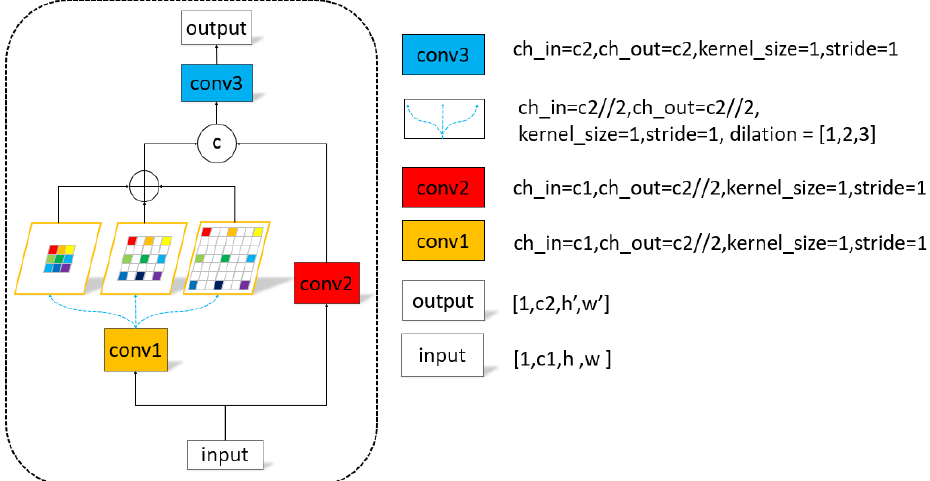
Figure 12. The trident block adopted in this study.